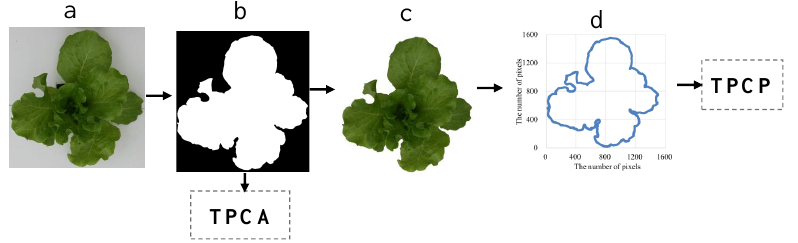
Figure 1. Extraction of TPCA and TPCP from lettuce canopy top view images; ( a ) top view image of lettuce canopy, ( b ) binarization in top view image of lettuce canopy, ( c ) background segmentation in top view image of lettuce canopy, ( d ) top projected canopy perimeter calculation.